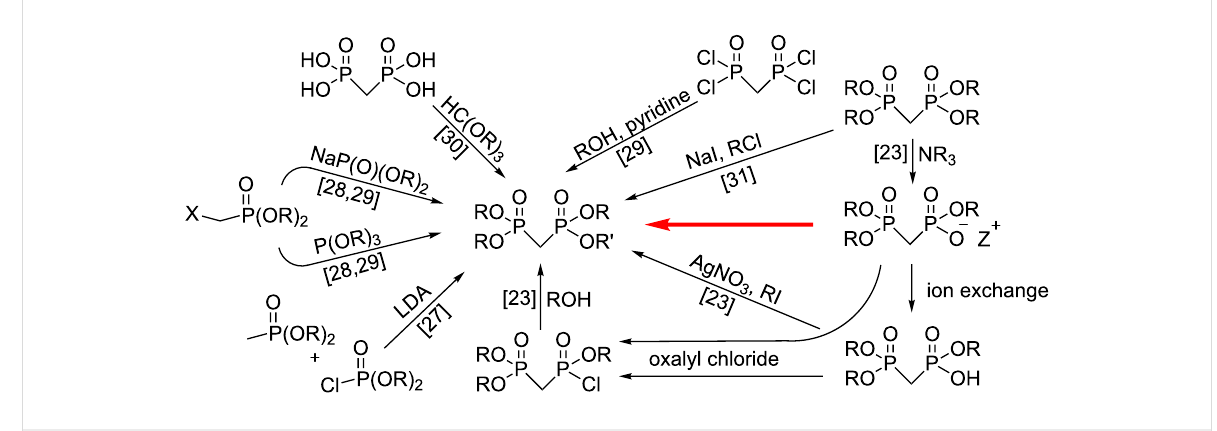
Scheme 1: Synthetic strategies for mixed tetraesters of medronic acid. The method described in this paper is marked with a red